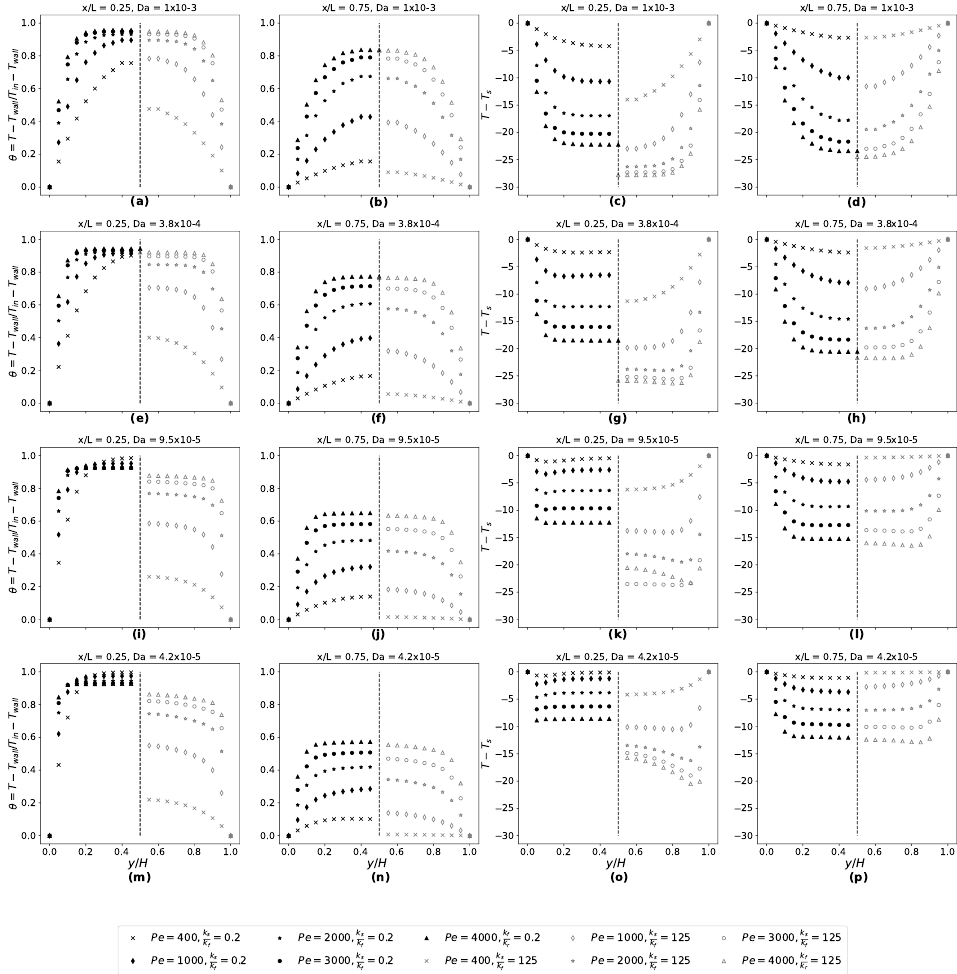
Figure 4. ( a – p ) Non-dimensional temperature and fluid–solid temperature difference for varying Pe and Da numbers. Values on the left hand side of the vertical dashed line (in black) are for a conductivity ratio of 0.2 and values on the right hand side of the dashed line (in grey) are for a conductivity ratio of